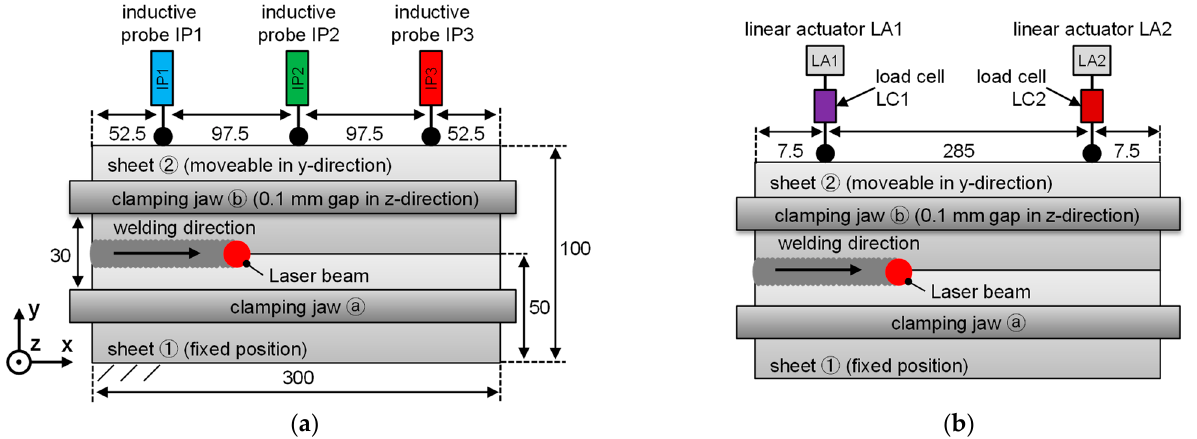
Figure 1. Schematic figure of the clamping situation and position of sensors and actuators (dimensions in millimeter): ( a ) Gap measurement via inductive probes IP1-3; ( b ) Linear actuators LA1-2 and force measurement via load cells LC1-2.